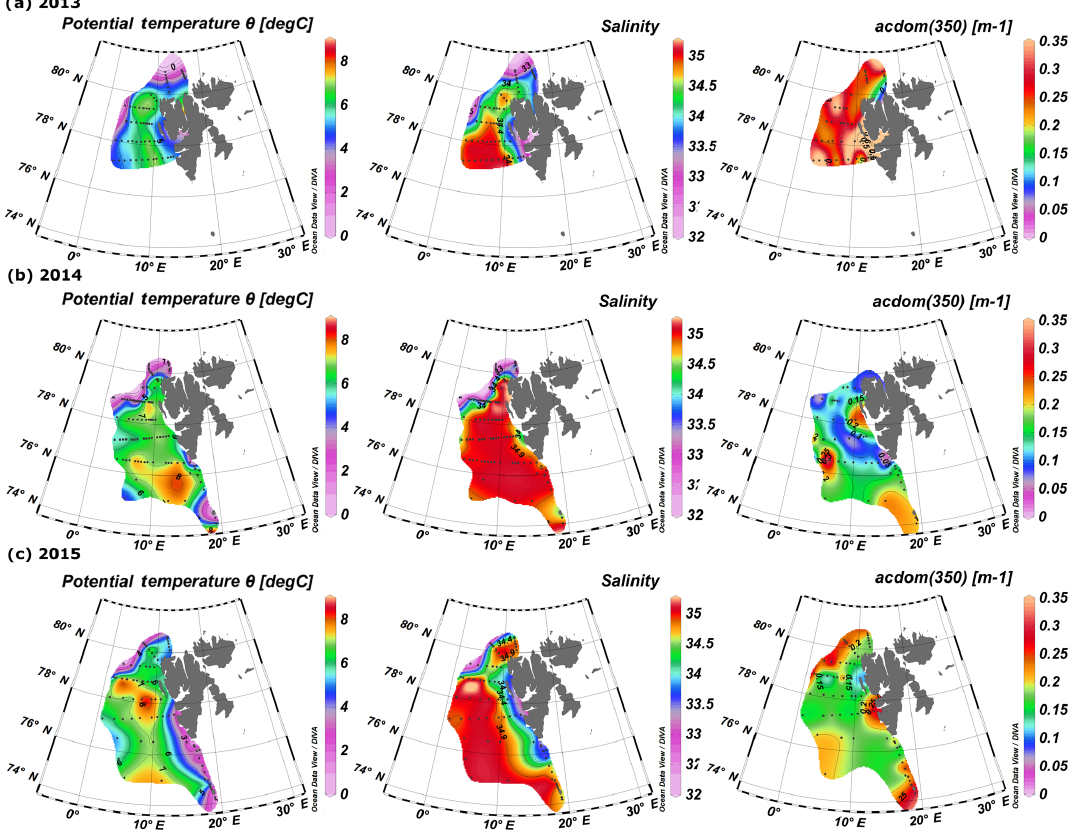
Figure 2. Surface distribution of temperature, salinity, and a CDOM (350) in 2013–2015 ( a–c , respectively). Plots were created with the use of Ocean Data View (Schlitzer,